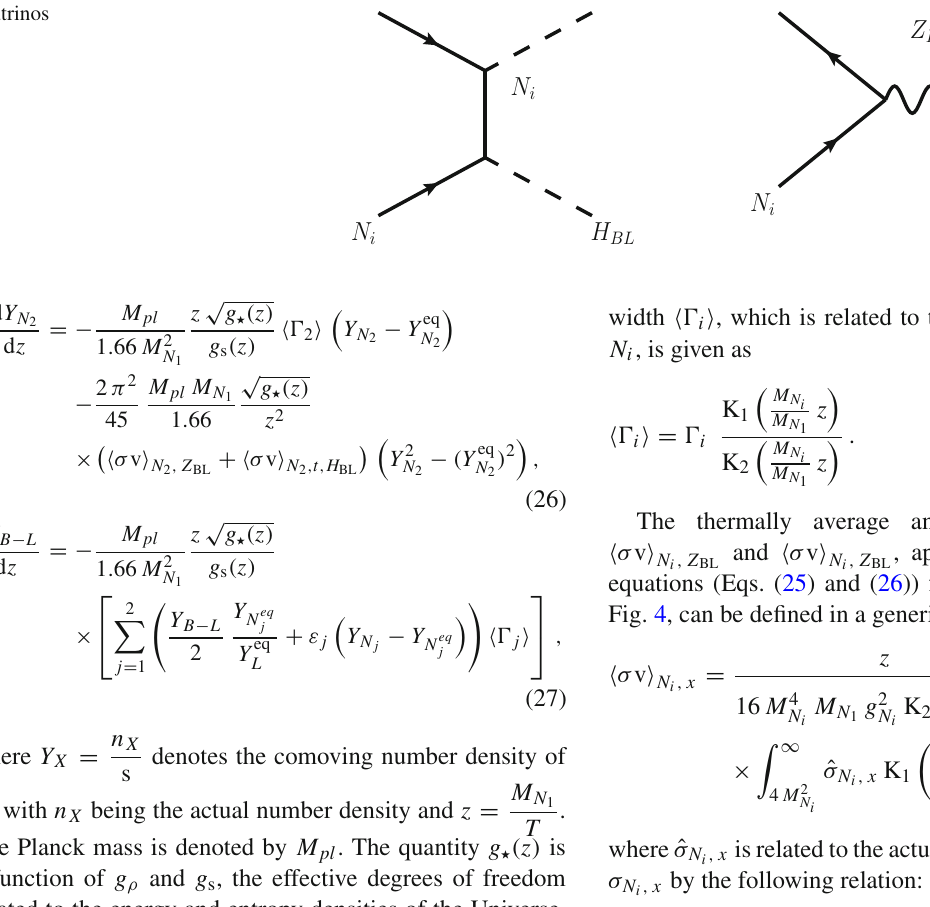
Fig. 4 Feynman diagrams for the annihilations of RH neutrinos